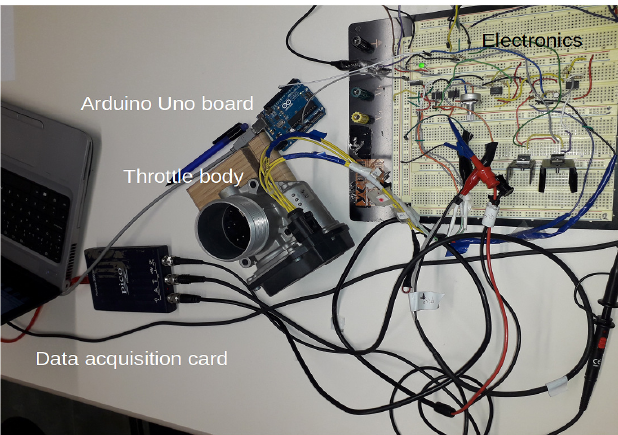
Figure 6. A photograph of the overall experimental platform.